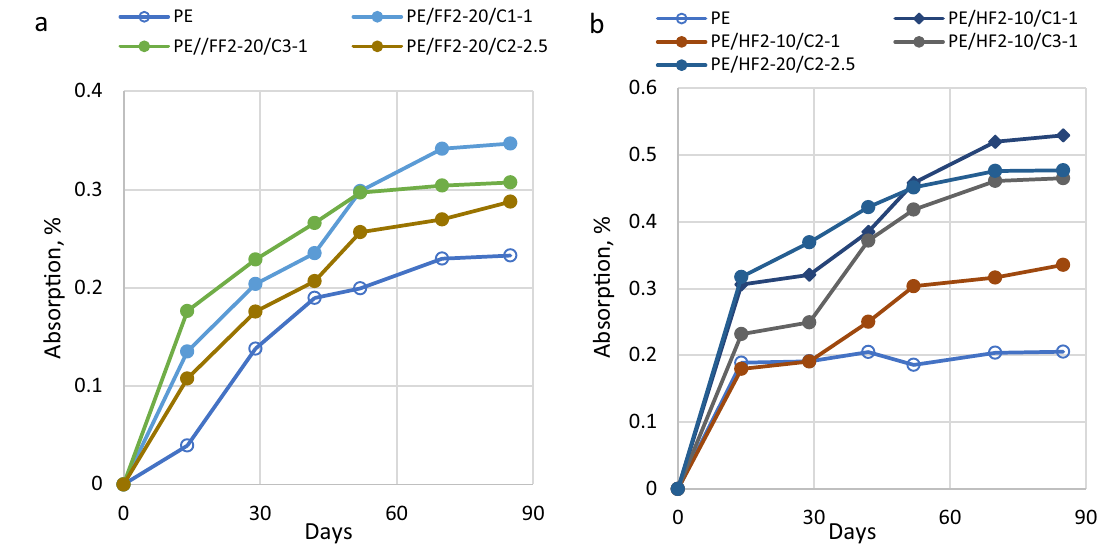
Figure 4. Moisture sorption bio-PE composites with flax or hemp fibers, at 50% RH.